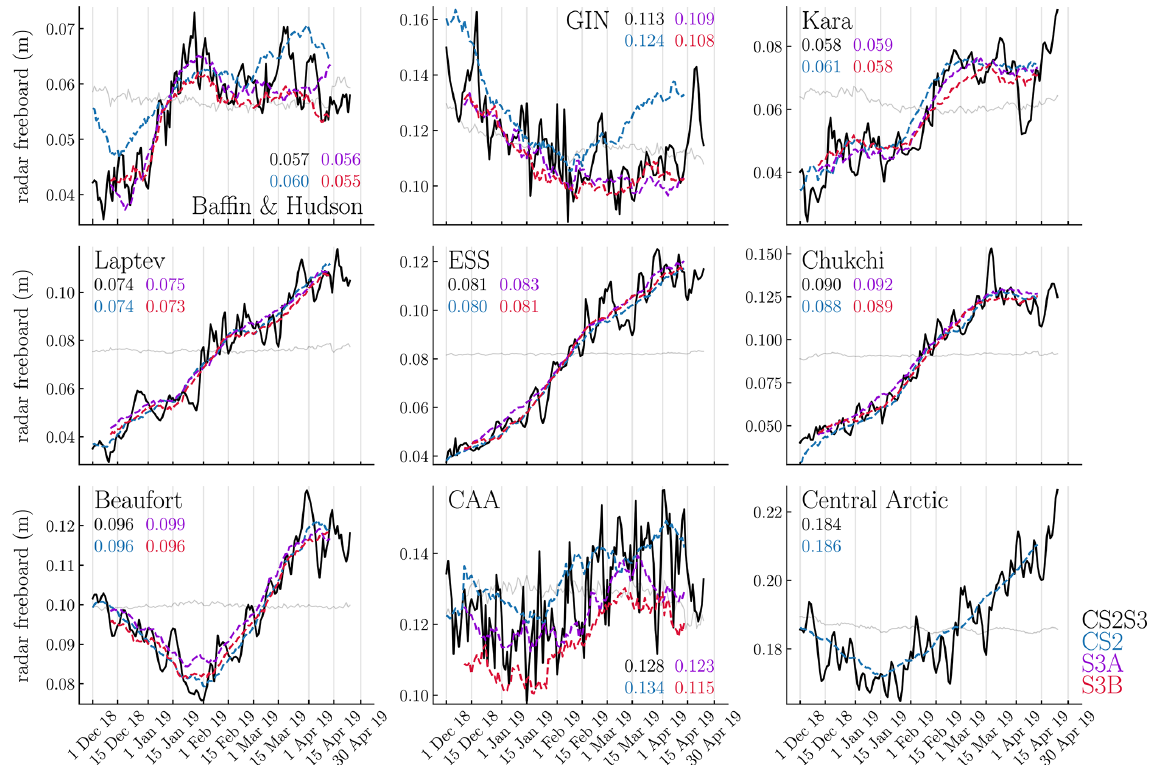
Figure 7. Comparison of CS2S3 time series and 31d running means of CS2 and S3 across nine Arctic sectors. Sectors are defined based on Fetterer et al. (2010) and are available from NSIDC. GIN: Greenland, Iceland, and Norwegian seas; ESS: East Siberian Sea; CAA: Canadian Archipelago. Values presented for each graph correspond to the mean (in metres) of each time series. All means are computed across the period 11 December 2018 to 12 April 2019 (the period where all four time series are available). Note that S3 time series are not included in the central Arctic as much of this region overlaps with the S3 polar hole > 81 . 5 ◦ N. Grey lines are the benchmark time series to test the efficacy of the model (see Sect.